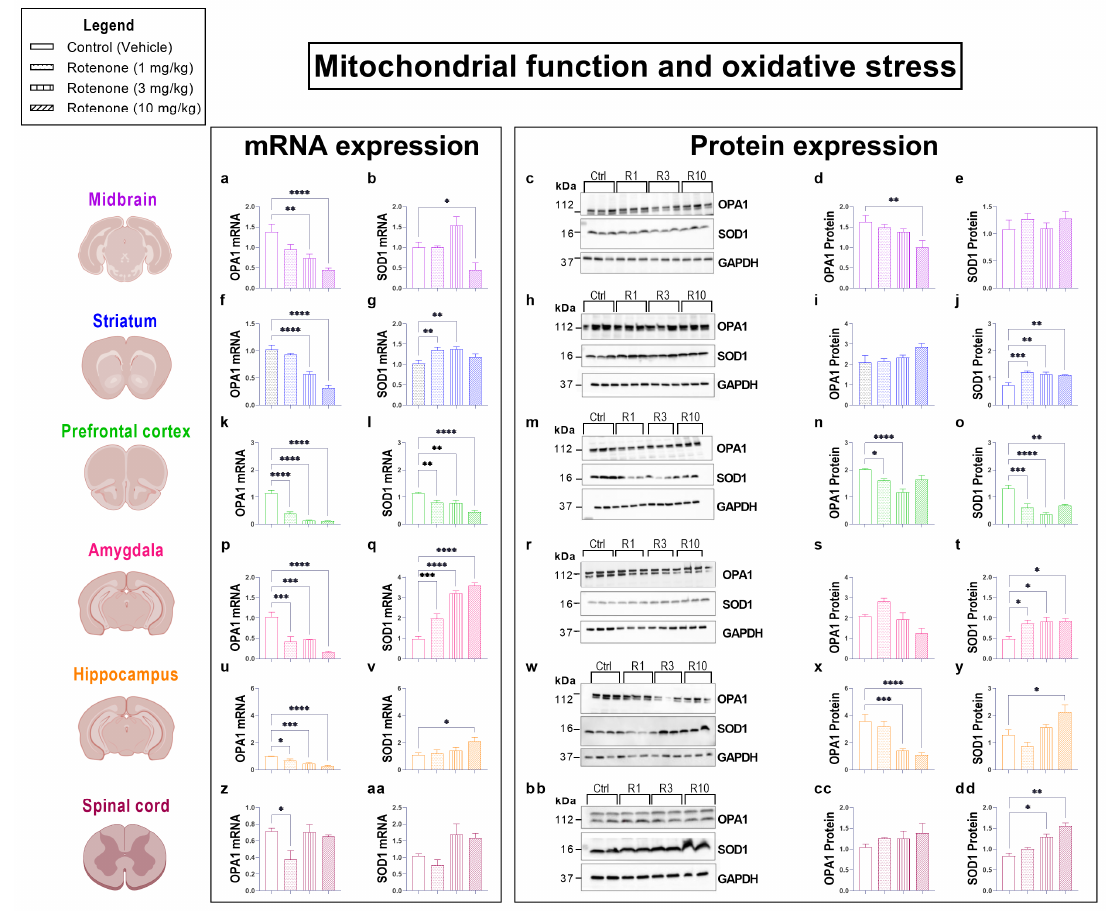
Figure 4. Rotenone increases oxidative stress in the brain and spinal cord. Oxidative stress was assessed by measuring the mRNA and protein expression of the mitochondrial marker OPA1 and the anti-oxidant enzyme SOD1. Real-time qPCR analyses of OPA1 and SOD1 mRNA expression in the midbrain ( a , b ), striatum ( f , g ), prefrontal cortex ( k , l ), amygdala ( p , q ), hippocampus ( u , v ) and spinal cord ( z , aa ) of mice administered with increasing dosages of rotenone (1, 3 and 10 mg/kg BW, i.p. per 21 days). Fold-changes were calculated using the ∆∆ Ct method after normalization to s18 (ribosomal protein s18 gene), the housekeeping gene. Each data point represents the mean value from n = 4 mice per each group. Representative Western blots and densitometry of OPA1 and SOD1 protein expression in the midbrain ( c – e ), striatum ( h – j ), prefrontal cortex ( m – o ), amygdala ( r – t ), hippocampus ( w – y ) and spinal cord ( bb – dd ) of mice exposed to the same treatment regimen as for mRNA studies. Protein expression was normalized to GAPDH, the loading control. Densitometric results are expressed as mean ± S.E.M from n = 4 mice per each group. * p < 0.05, ** p < 0.01, *** p < 0.001 or **** p < 0.0001 as determined by one-way ANOVA followed by Dunnett’s post hoc test. Ctrl: control; R1, 3, 10: Rotenone (1, 3, 10 mg/kg); OPA1: Mitochondrial dynamin like GTPase; SOD1: superoxide dismutase 1; GAPDH: glyceraldehyde 3-phosphate dehydrogenase; kDa: Kilodalton. Analyses of OPA1 transcripts revealed that both 3 mg/kg and 10 mg/kg rotenone (but not the 1 mg/kg) significantly down-regulated OPA1 mRNA expression in the midbrain (** p = 0.0033 vs. vehicle [3 mg/kg rotenone], and **** p < 0.0001 [10 mg/kg rotenone]; F (3, 28) = 9.736; Figure 4a) and striatum (**** p < 0.0001, 3 mg/kg and 10 mg/kg rotenone, respectively; F (3, 28) = 33.67; Figure 4f). All rotenone dosages down-regulated OPA1